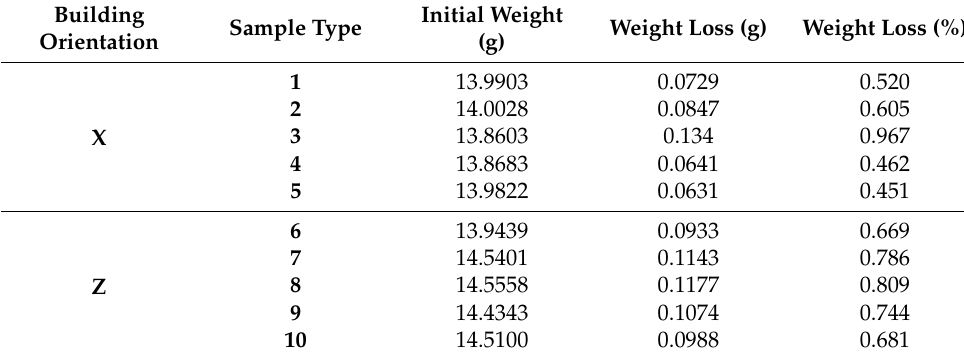
Table 5. Summary of samples’ initial weights and weight